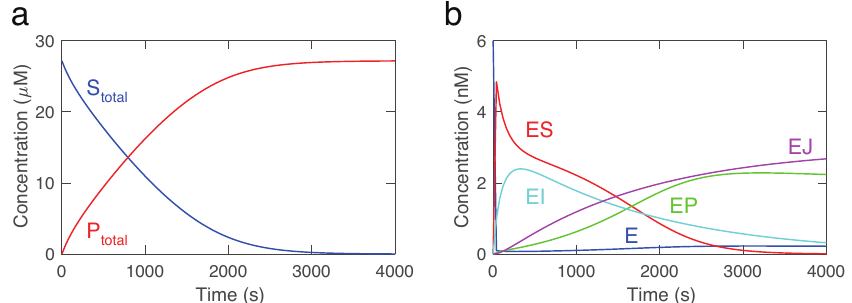
Figure 4. Simulation of the created SBML model for the HIV model. ( a ) S total and P total represent the total S concentration ( S total = S + ES ) and the total P concentration ( P total = P + EP ), respectively. ( b ) E , ES , EP , EI , and EJ represent the enzyme, enzyme-substrate complex, enzyme-product complex, enzyme-inhibitor complex, irreversible enzyme-inhibitor complex, respectively. Not all variables are shown, for clarity. This model was created by KinModGPT with text-davinci-003 . We tuned the kinetic parameters before the